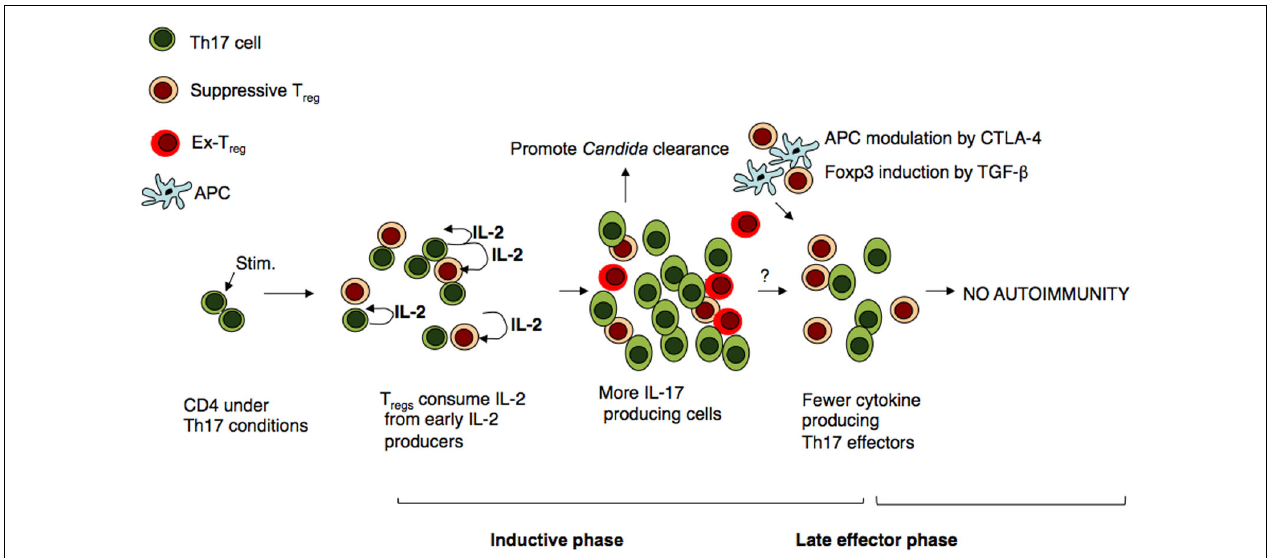
T regs also lose Foxp3 expression (Ex-T reg ), which also likely contributes to the absence of suppression. However,T regs enhance IL-17 production by consuming IL-2.This promotes clearance of pathogens that require protective Th17 responses. However when the cytokine levels drop at later phases,T regs limitTh17 cells, likely by other mechanisms such asTGF- β and APC modulation by